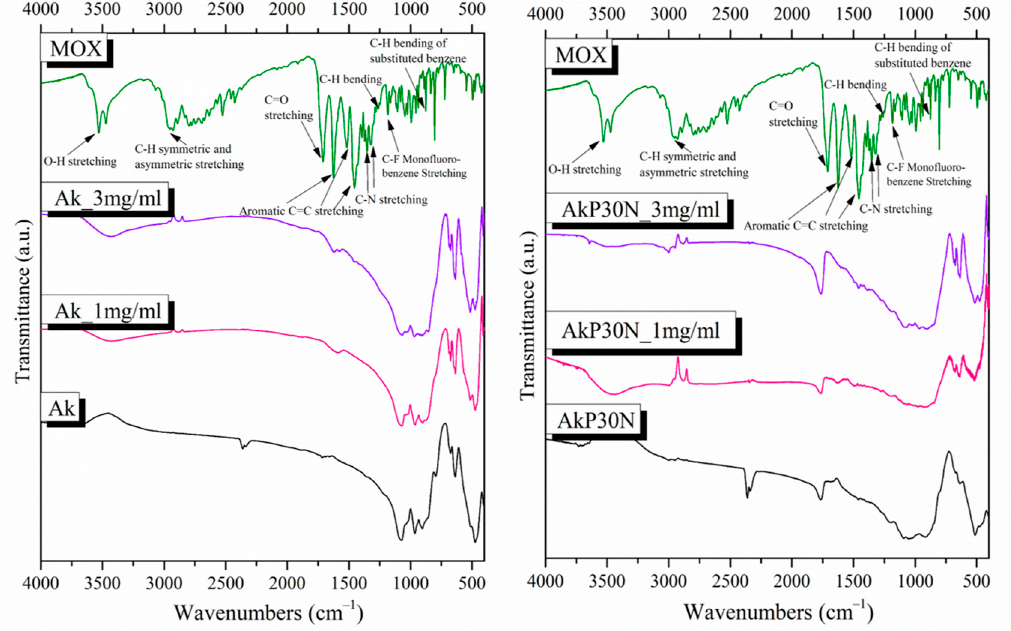
Figure 21. FTIR spectra of the scaffolds before and after drug encapsulation: akermanite ceramic scaffolds (Ak) and composite akermanite/PLGA/NPs scaffolds (AkP30N).